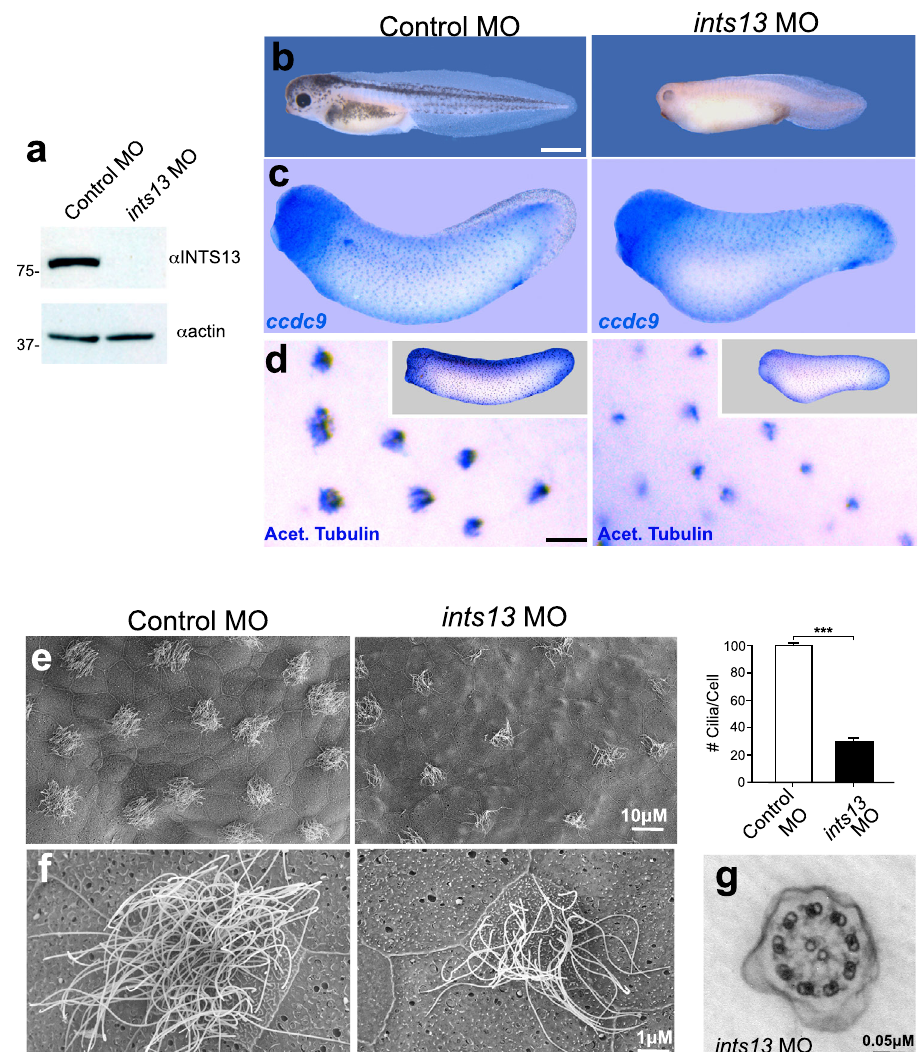
Fig. 7 | INTS13 is required for embryonic development and ciliogenesis in Xenopus laevis. a Western blot showing that the INTS13 MO was able to deplete INTS13 protein in Xenopus embryos and molecular weight markers shown are in kilodaltons. b In comparison to control embryos, morpholino (MO)-mediated knockdownofINTS13inXenopusleadstoseveredevelopmentaldefectsincluding a small head, big belly, short and down curved body axes, cardiac edema and massive developmental delay. Scale bar represents 500 μ M. c In situ hybridization using a speci fi c probe for the multi-ciliated cell (MCC) marker ccdc9 shows a reductioninccdc9expressioninMCCofmorphantscomparedtocontrolembryos. d Wholemountantibodystainingforacetylated α -tubulinshowsapunctatepattern similartoccdc9.Thepunctahaveamorecondensedandstrongersignalincontrol embryos. A higher magni fi cation view of the MCC shows marked reduction in cilia compared to controls. b – d n >60 control or morphants embryos were used